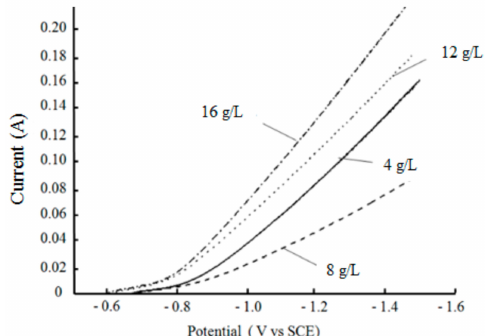
Figure 9. Cathodic polarization curves tested in solutions containing di ff erent concentrations of nanodiamond powder.